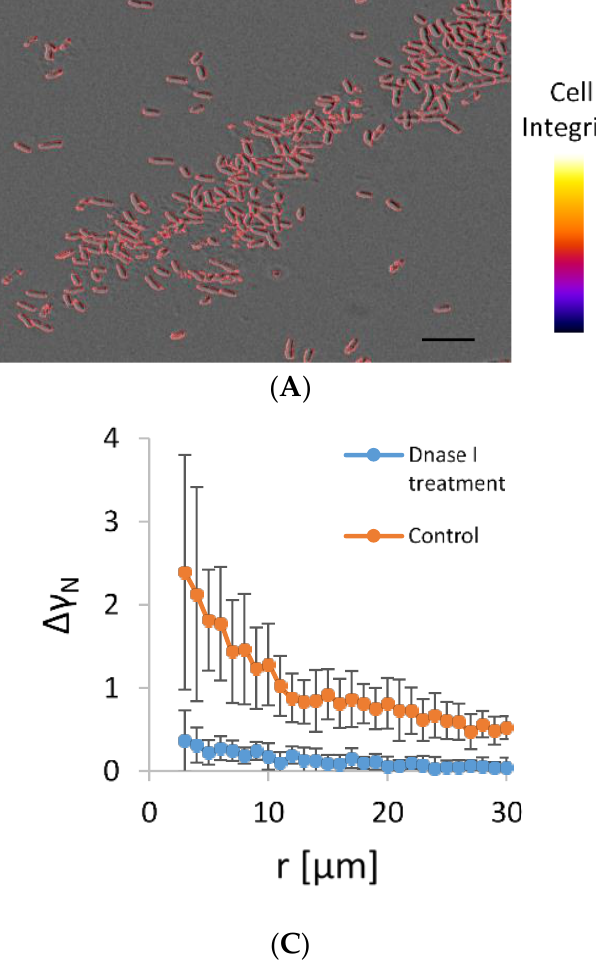
Figure 4. Panel ( A ) is a DIC micrograph of bacterial aggregate in the early stationary growth phase. Only high-contrast objects that include predominantly cells of high cell integrity likely to represent viable bacteria are outlined. In panel ( B ), an overlay of fluorescence image of the same bacterial aggregate stained by healthy cell impermeable DNA stain TOTO-1 and an image of colour-coded contrast intensity (Cell integrity) of DIC image is shown. Bright green fluorescence objects are the dying bacterial cells. The cells that were alive are not visible on fluorescence images and are marked by colour-coded DIC contrast intensity. Small fluorescence particles released from the dying cells swarmed around the dying cells. The scale bar corresponds to 10 µm. Panel ( C ) shows a pair-wise correlation function (Equation (3) applied on microscopy images of concentrated bacterial culture in exponential growth phase treated with DNase I for 30 min at 37 °C; control under the same conditions, but without DNase I.